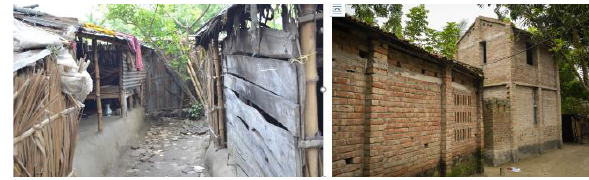
Figure 3: the previous and present condition of housing Co-creation Architects is an architectural firm, which provides services to both low-income and middle- income group of people. POCAA is a platform for group of architects who introduce themselves as ‘community architect’. POCAA began its journey with an intention to work for disadvantaged